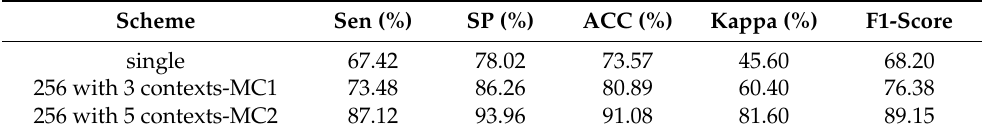
Table 6. The effect of the multi-context of the CBIS-DDSM test ROI.